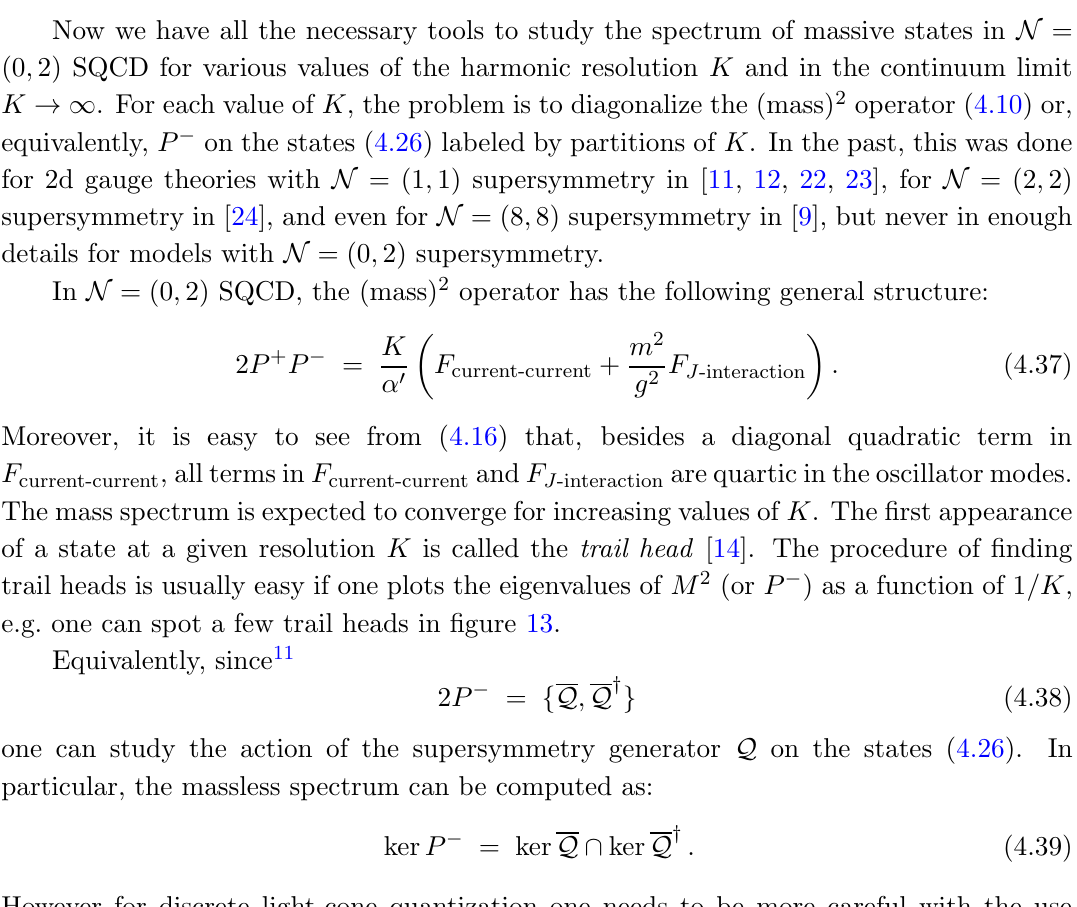
Figure 13 . DLCQ spectrum of light ( M 2 < 1 : 5 in units of 2 g 2 N c ) (cid:13)avor-singlet mesons and glueballs in N = (0 ; 2) SQCD with N 1 = N 2 = N 3 and g = m